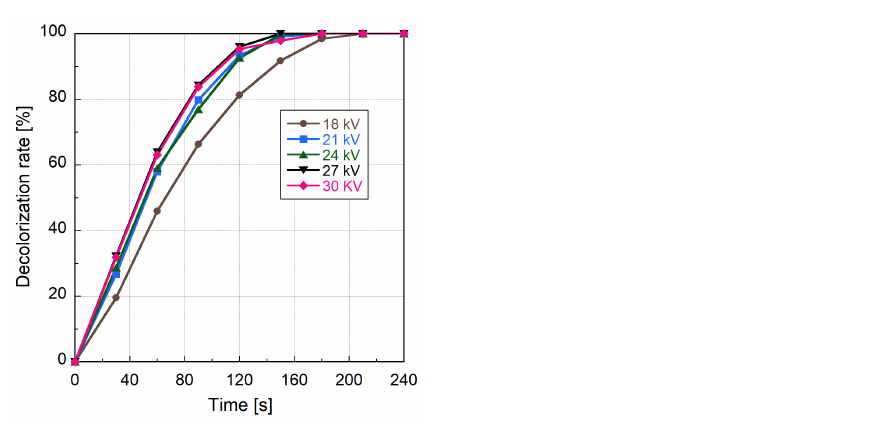
Figure 8. Decolorization rates of indigo carmine as a function of treatment time with various peak values of applied pulsed voltage. Pulsed streamer discharges with a repetition frequency of 100 pps were irradiated to the 10 mg/L indigo carmine solution in the overflow-type reactor. The solution was circulated with a flow rate of 600 mL/min.